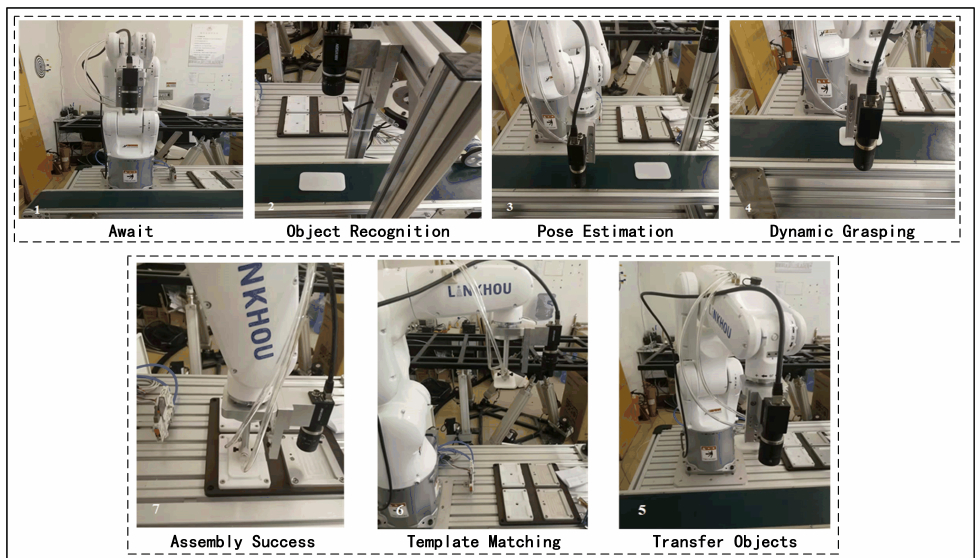
Figure 14. Overall assembly process.